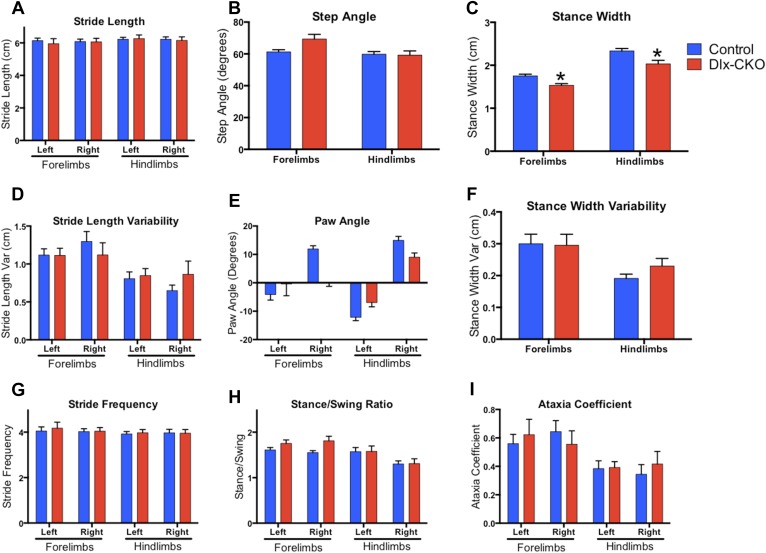
Dlx-CKO mice exhibit normal motor function during gait.(A–I) results from digigait analysis. Genotype differences were present in stance width (two-way ANOVA main effect of genotype F1,62 = 16.51, p < 0.0001; limb F1,62 = 70.90, p < 0.0001; Interaction F1,62 = 0.381, p = 0.539, Sidak's multiple comparisons test), but no other abnormalities were observed.